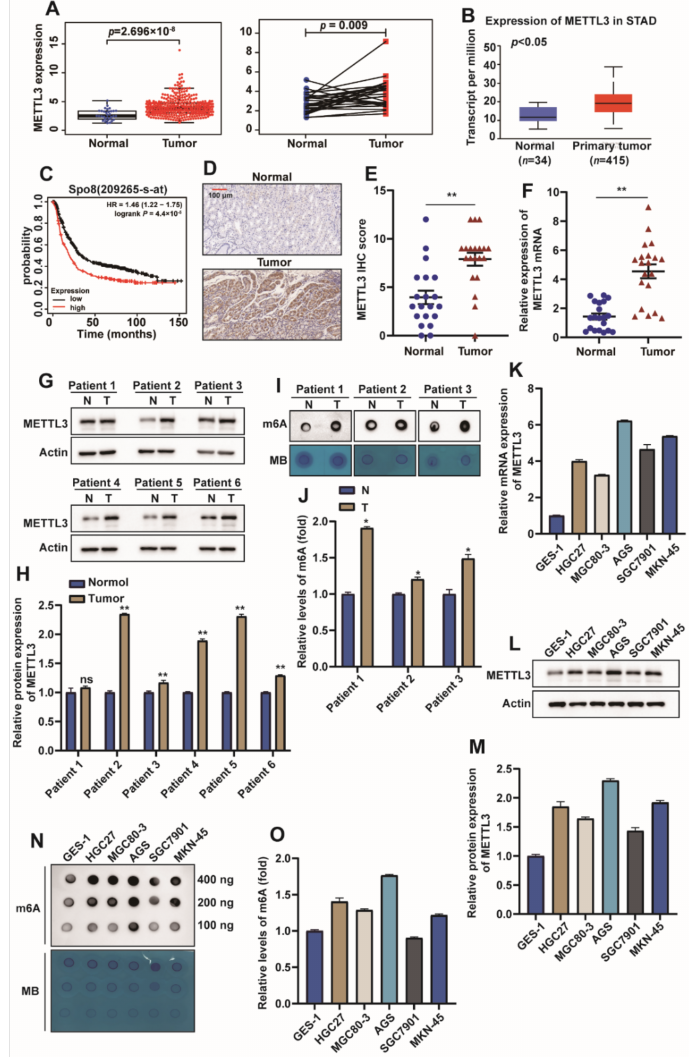
Figure 1. METTL3 is highly expressed in GC. ( A ) The expression levels of METTL3 in gastric cancer tissues and normal tissues were analyzed in the TCGA database. ( B ) The expression level of METTL3 in gastric cancer was analyzed by UALCAN. ( C ) The relationship between the expression level of METTL3 and prognosis was analyzed in the TCGA database. ( D ) Representative images of METTL3 immunohistochemistry (IHC) of normal GC tissue (left) and GC tissue (right) (scar bar = 100 µ m). ( E ) Calculated GGCT immunohistochemical scores in GC group ( n = 20) and normal group ( n = 20). ( F ) The mRNA level of METTL3 was detected by qPCR in GC normal tissues and cancer tissues, and Actin was used as an internal control. ( G , H ) The protein expression level of METTL3 in GC tissues and normal tissues was detected by Western blot, and the gray value of the experimental results was analyzed and normalized by Actin ( n = 3). ( I , J ) The m6A modification level of mRNA in GC tissue and normal tissue was detected by dot blot experiment, in which the total amount of RNA used in each spot was 400 ng, and the experimental results were quantitatively analyzed. ( K ) qPCR detection of METTL3 mRNA levels in human gastric mucosa normal epithelial cells (GES1) and cancer cells (MGC80-3, HGC27, AGS, SGC7901, MKN-45); Actin was used as an internal control ( n = 3). ( L , M ) The protein levels of METTL3 in human gastric mucosa normal epithelial cells (GES1) and cancer cells (MGC80-3, HGC27, AGS, SGC7901, MKN-45) were detected by Western blot, and were normalized with Actin ( n = 3). ( N , O ) Dot blot assay to detect the m6A modification level of mRNA in GES1, MGC80-3, HGC27, AGS, SGC7901, MKN-45 cells, and the dot blot results for 100 ng, 200 ng and 400 ng RNA amounts were quantified separately and compared to GES-1 cells, then averaged and counted ( n = 3). (*: p < 0.05, **: p <